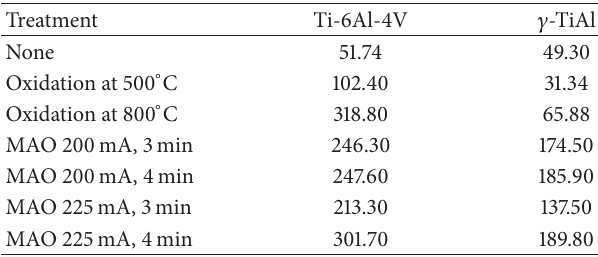
Table 1: Average roughness values (in 𝜇 m) measured on Ti alloy sample surfaces for various treatments using